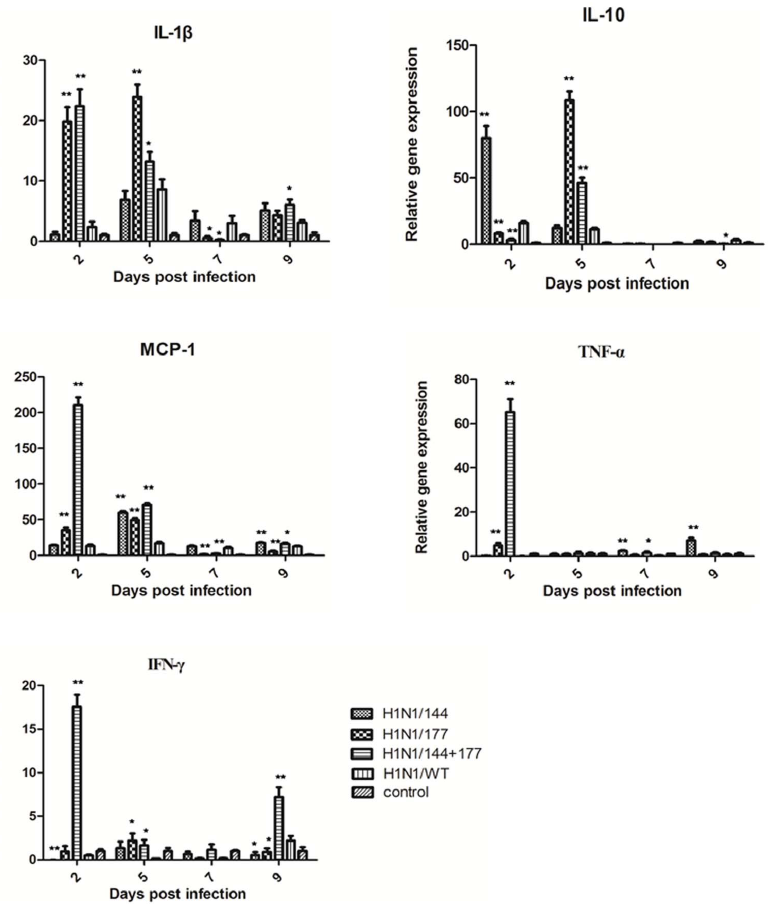
Figure 5. The levels of antiviral and proinflammatory cytokines in lung of infected mice. Determination of IL-1, IL-10, MCP-1, TNF- a and IFN- c levels in H1N1/144, H1N1/177, H1N1/144 + 177 or H1N1/WT-infected mouse lungs at 2, 5, 7, 9 d.p.i. The statistical analysis was performed using Student’s t test. *, P , 0.05; **, P , 0.01 between the recombinant mutants and H1N1/WT.